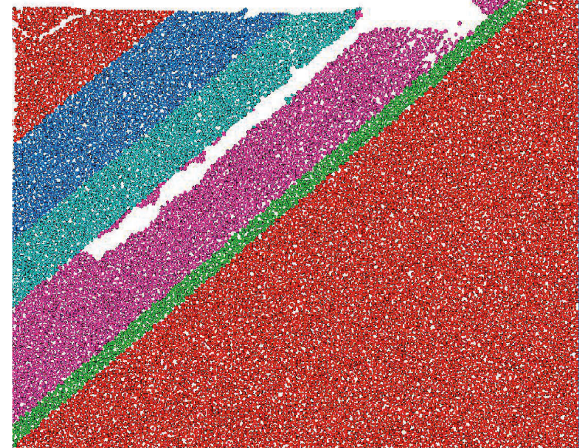
Figure 11: Multicycle-sequence coal